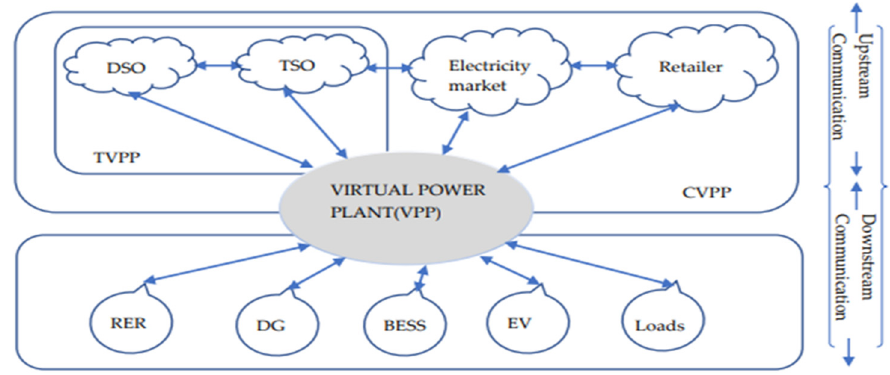
Figure 2. Concept of VPPs communication [20] .